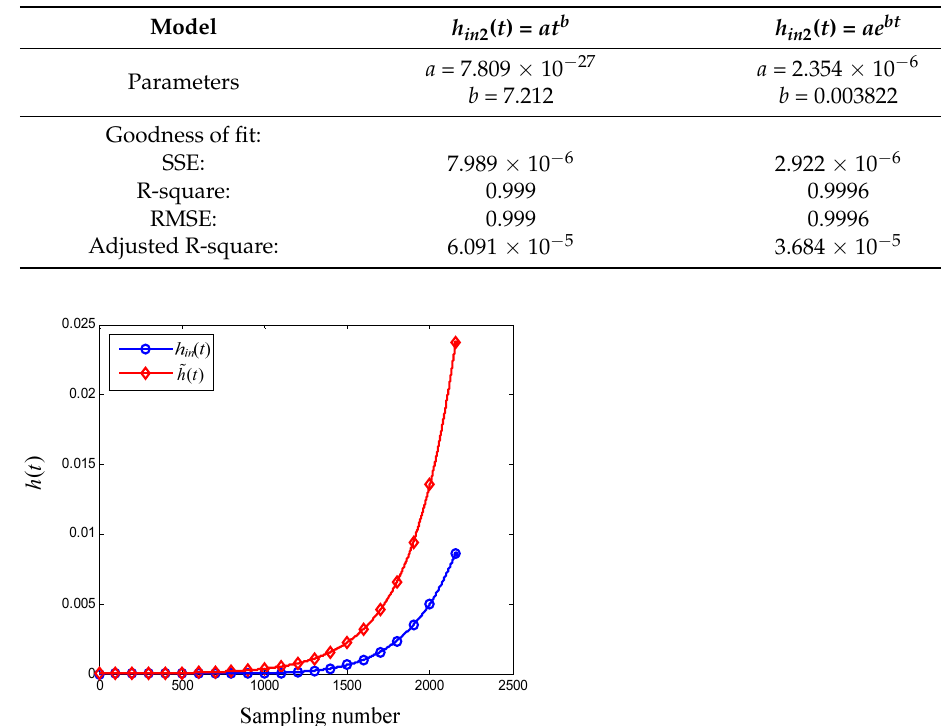
Figure 9. The scatter diagram and the fitted function of initial reliability R in 2 ( t ) . Table 4. The fitted model and parameters of h in 2 ( t ) .